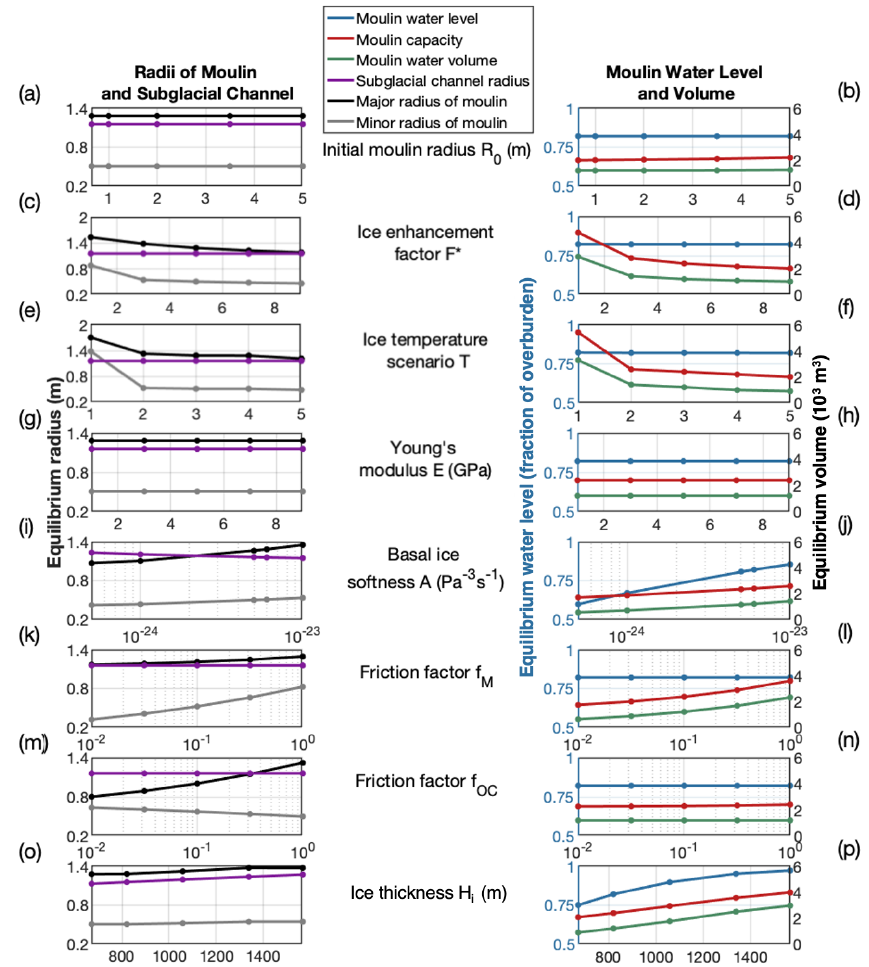
Figure 3. Results of parameter sensitivity studies for 40d MouSh model runs. Shown are the sensitivity of moulin size to initial condition for moulin radius (a, b) , enhancement factor for englacial ice (c, d) , ice temperature scenario (e, f) , Young’s modulus (g, h) , softness of basal ice (i, j) , friction factor for water flow beneath the water line (k, l) , friction factor for water flow above the water line (m, n) , and ice thickness (o, p) . The left column shows the moulin radii (black and grey) at the mean water level and the mean subglacial channel radius (purple) averaged over the final 24h period of the 40d model run. The right column shows the equilibrium water level (blue), moulin capacity (red), and volume of water in the moulin (green) averaged over the same 24h period. Overall, moulin radius is most sensitive to the friction factors, while moulin water level and volume are most sensitive to ice thickness (also an indicator of the hydraulic potential gradient) and basal ice softness. Note the different y -axis range in panels (c) and (e)